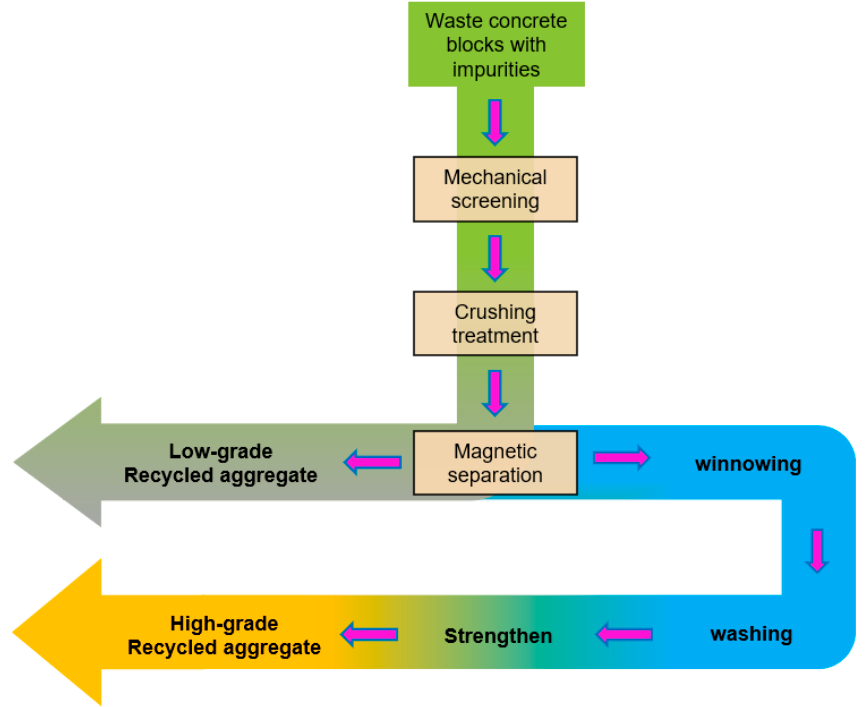
Figure 1. Common production process of recycled aggregate.